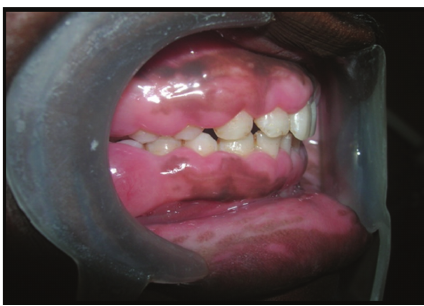
Figure 2: Male patient with gingival enlargement in milder form (preoperative